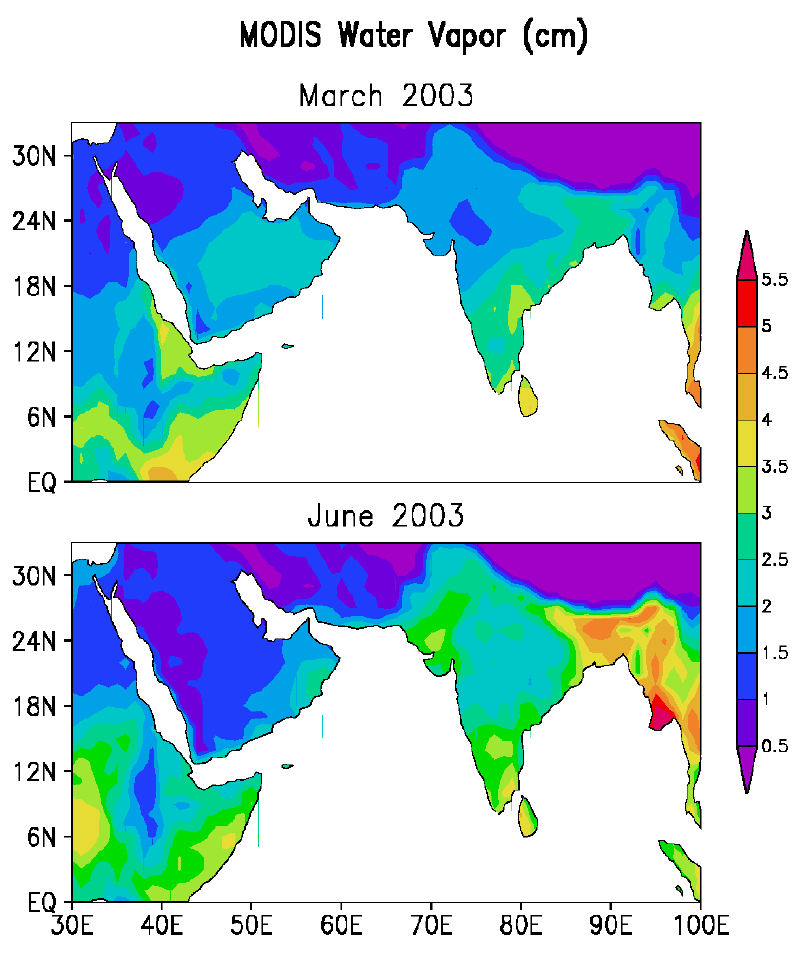
Fig. 11. Clear-sky column water vapour content derived from MODIS data using a near-infrared